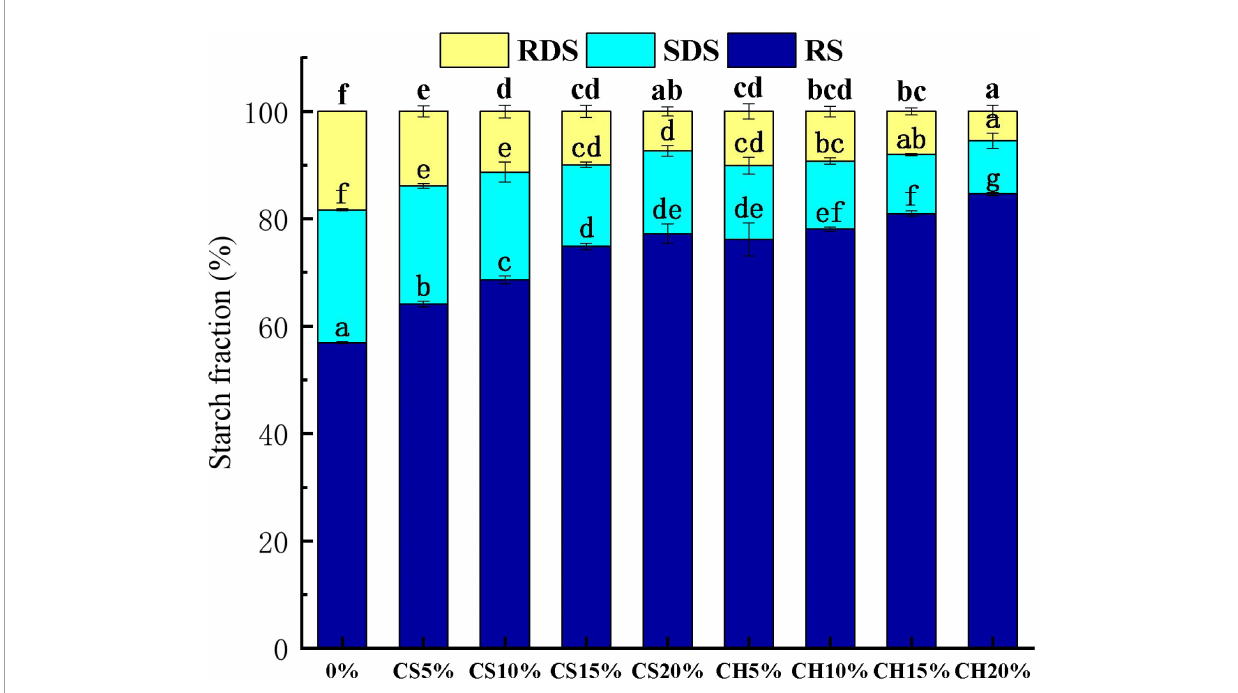
FIGURE4 The percentages of RDS, SDS and RS content of biscuits with different addition ratio of CS and CH. RDS, fast digestion starch; SDS, slow digestion starch; RS, resistant starch; CS 5, CS 10, CS 15, and CS 20% were CS-biscuits at different addition ratio (CS/flour = 5, 10, 15, and 20%); CH 5%, CH 10%, CH 15% and CH 20% were CH-biscuits at different addition ratio (CH/flour = 5, 10, 15, and 20%); CH indicates chitin; CS indicates crayfish shell.